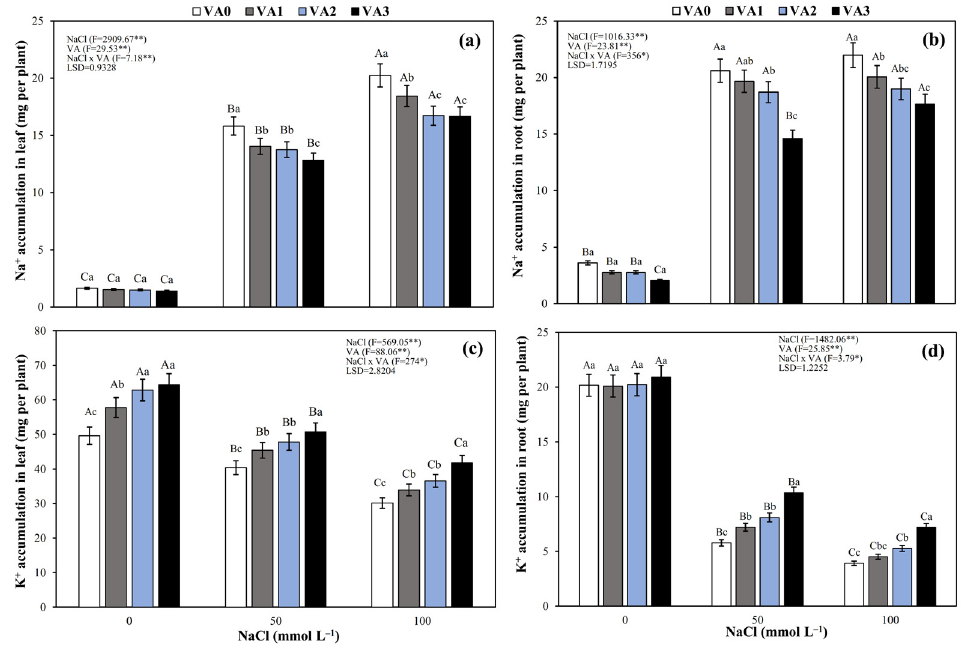
Figure 7. Na + content in leaves ( a ) and roots ( b ); K + content in leaves ( c ) and roots ( d ) of soybean plants under different levels of salt stress and VA applications. Plants were submitted to four concentrations of VA (VA0, non-VA application; VA1, 0.4 mL L − 1 ; VA2, 0.8 mL L − 1 ; and VA3, 1.2 mL L − 1 ) and three levels of NaCl (0, 50, and 100 mmol L − 1 ). Data are mean ± SD (n = 5). Uppercase letters above bars indicate significant differences among NaCl concentrations at the same VA concentration. Lowercase letters above bars indicate differences among VA concentrations at the same NaCl concentration, according to LSD test ( p < 0.05). F values from ANOVA: ** p < 0.01, * p < 0.05.